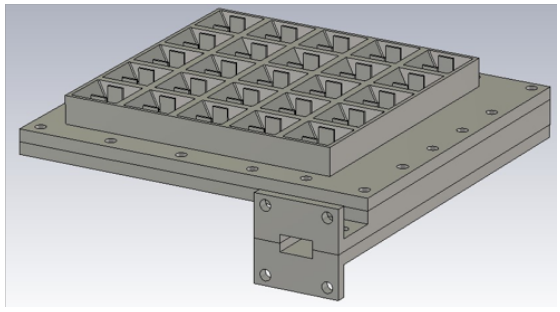
Figure 7. Schematic of the designed structure with